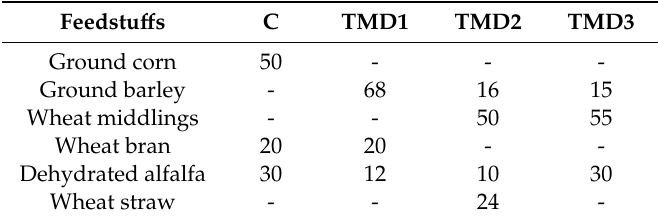
Table 1. Formulation (g / 100 g) of the control (C) and the experimental diets (TMD1–TMD3) for black soldier fly larvae (BSFLs). Feedstu ff s C TMD1 TMD2 TMD3 Ground corn 50 - - - Ground barley - 68 16 15 Wheat middlings - - 50 55 Wheat bran 20 20 - - Dehydrated alfalfa 30 12 10 30 Wheat straw - - 24